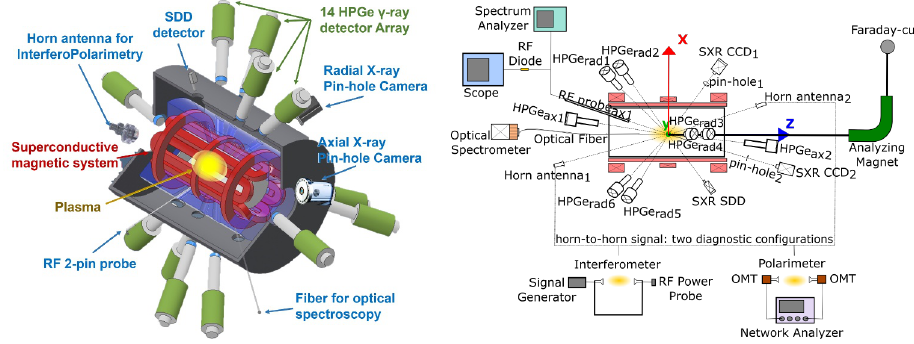
Figure 1. Rendering (left) and sketch (right) of the PANDORA setup with the systems used to measure in-plasma activity (14 HPGe detector array) and monitor plasma properties (multi-diagnostics